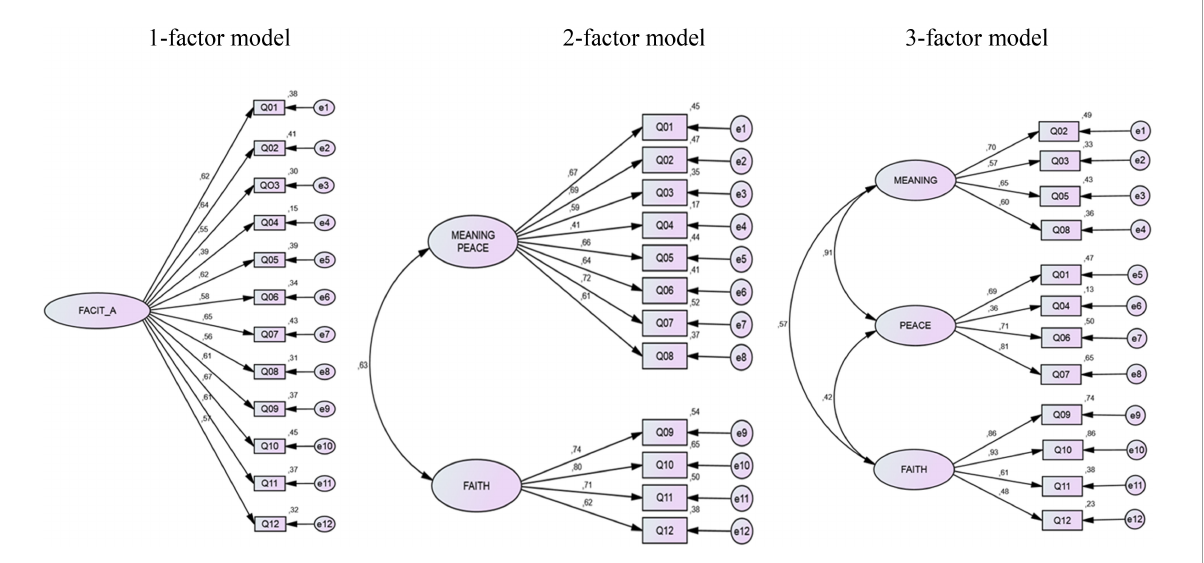
FIGURE1 Pathway—measurement model for the one-, two- and three-factor structures of the